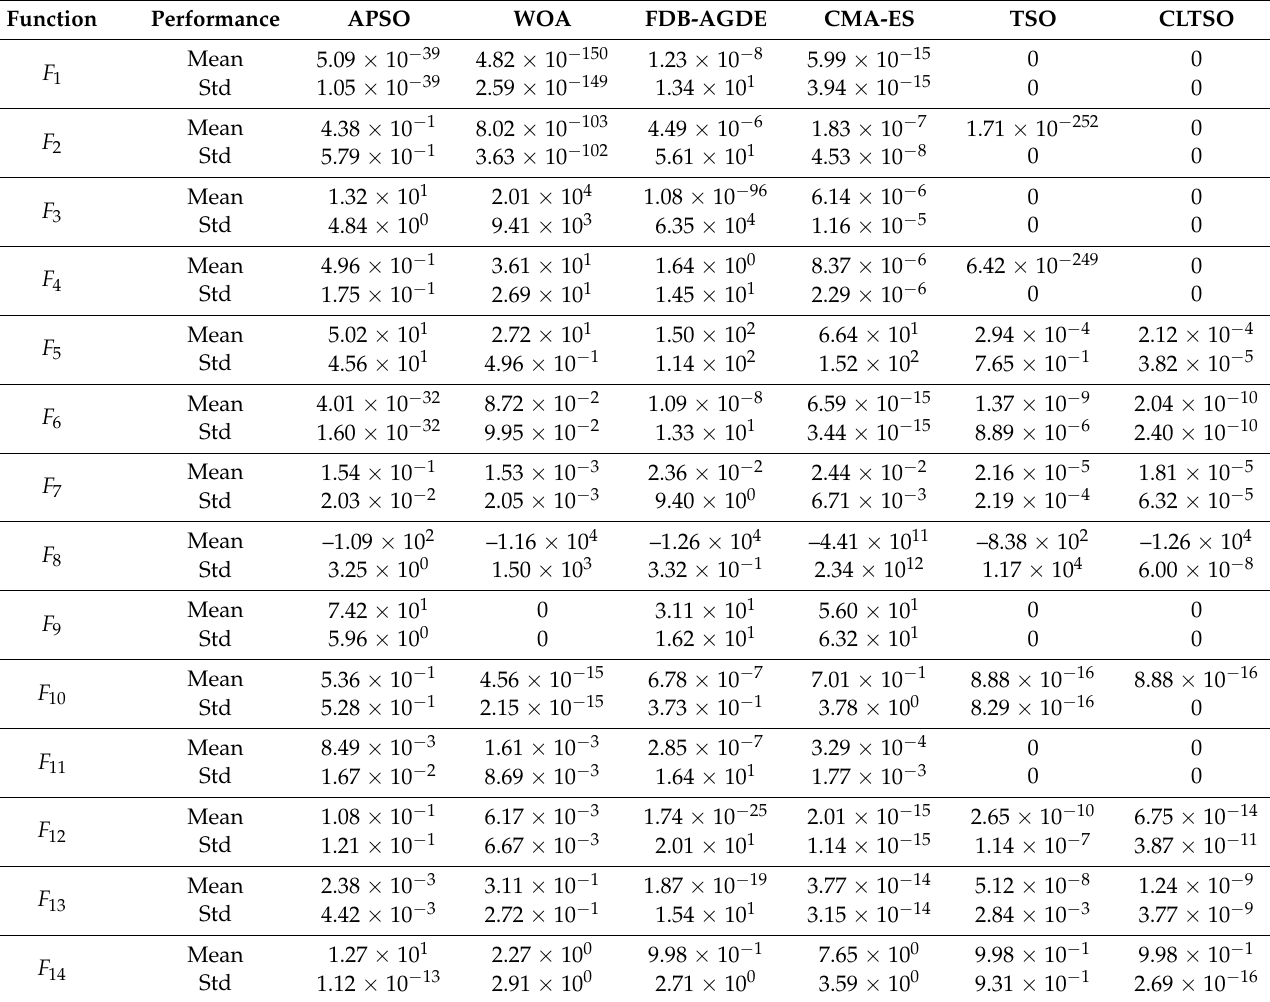
Table 4. Experimental results in 30